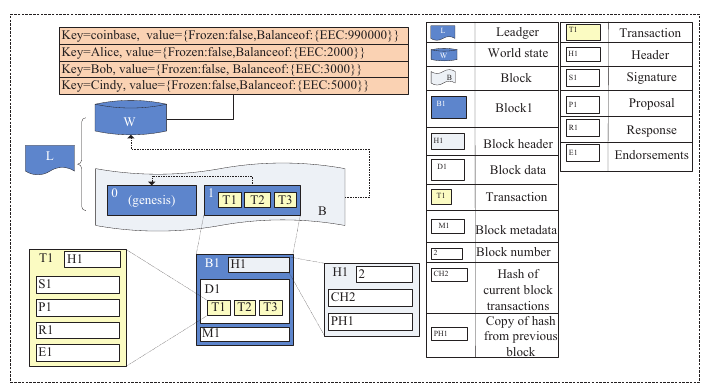
Figure 4. Struture of Fabric shared